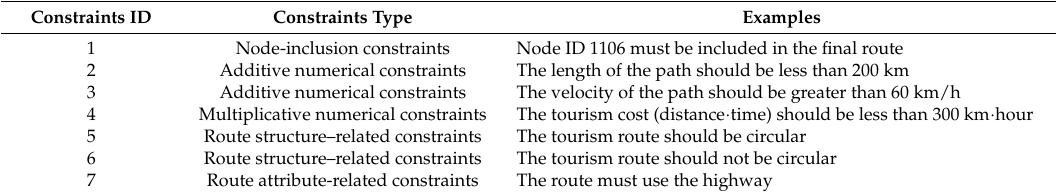
Table 2. Table of constraints in the case studies.